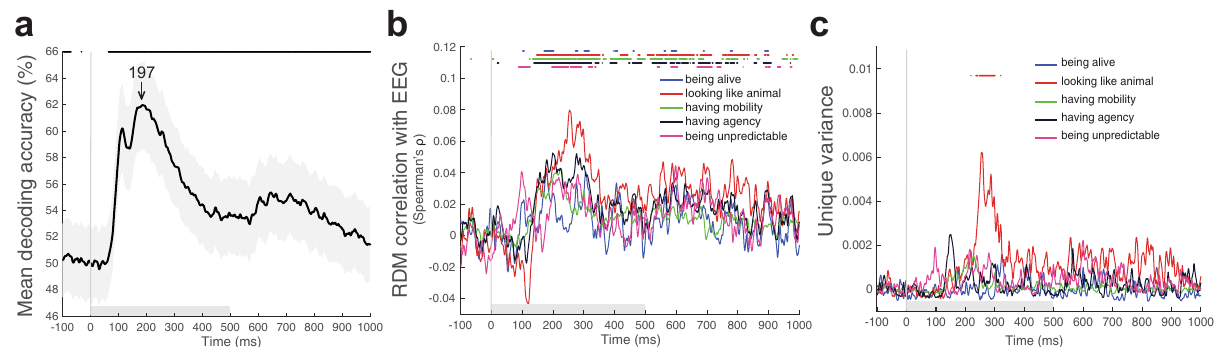
Fig. 6 Dimensions of animacy and EEG time course. a Mean decoding curve across 19 participants (pairwise stimuli decoding using a support vector machine approach). Signi fi cant decoding is indicated by a horizontal line above the graph (one-sided Wilcoxon signed-rank test, p < 0.05 corrected) and starts at 43 ms ( + / − 2 ms, standard error) with a peak latency of 197 ms ( + / − 7 ms, standard error, indicated by an arrow). The shaded area around the lines shows the standard error of the mean based on single-participant decoding. The grey horizontal bar on the x axis indicates the stimulus duration. b Animacy dimension RDM comparison with EEG RDMs across time. Lines show the correlation between the EEG RDMs and each animacy dimension RDM. A signi fi cant correlation is indicated by a horizontal line above the graph (one-sided Wilcoxon signed-rank test, p < 0.05 corrected). The grey horizontal bar on the x -axis indicates the stimulus duration. c Unique variance of each animacy dimension in explaining EEG RDMs computed using a GLM. For each animacy dimension, the unique variance is computed by subtracting the total variance explained by the reduced GLM (excluding the animacy dimension of interest) from the total variance explained by the full GLM, using non-negative least squares to fi nd optimal weights. A signi fi cant unique variance (between 237 and 301 ms) is indicated by a horizontal line above the graph (one-sided Wilcoxon signed-rank test, p < 0.05 corrected). The grey horizontal bar on the x axis indicates the stimulus MDS plots colour-coded according to binary animacy dimensions (e.g., “ being alive ” with one colour of dots and “ not being alive ” with another colour of dots, Supplementary Fig. 1). All